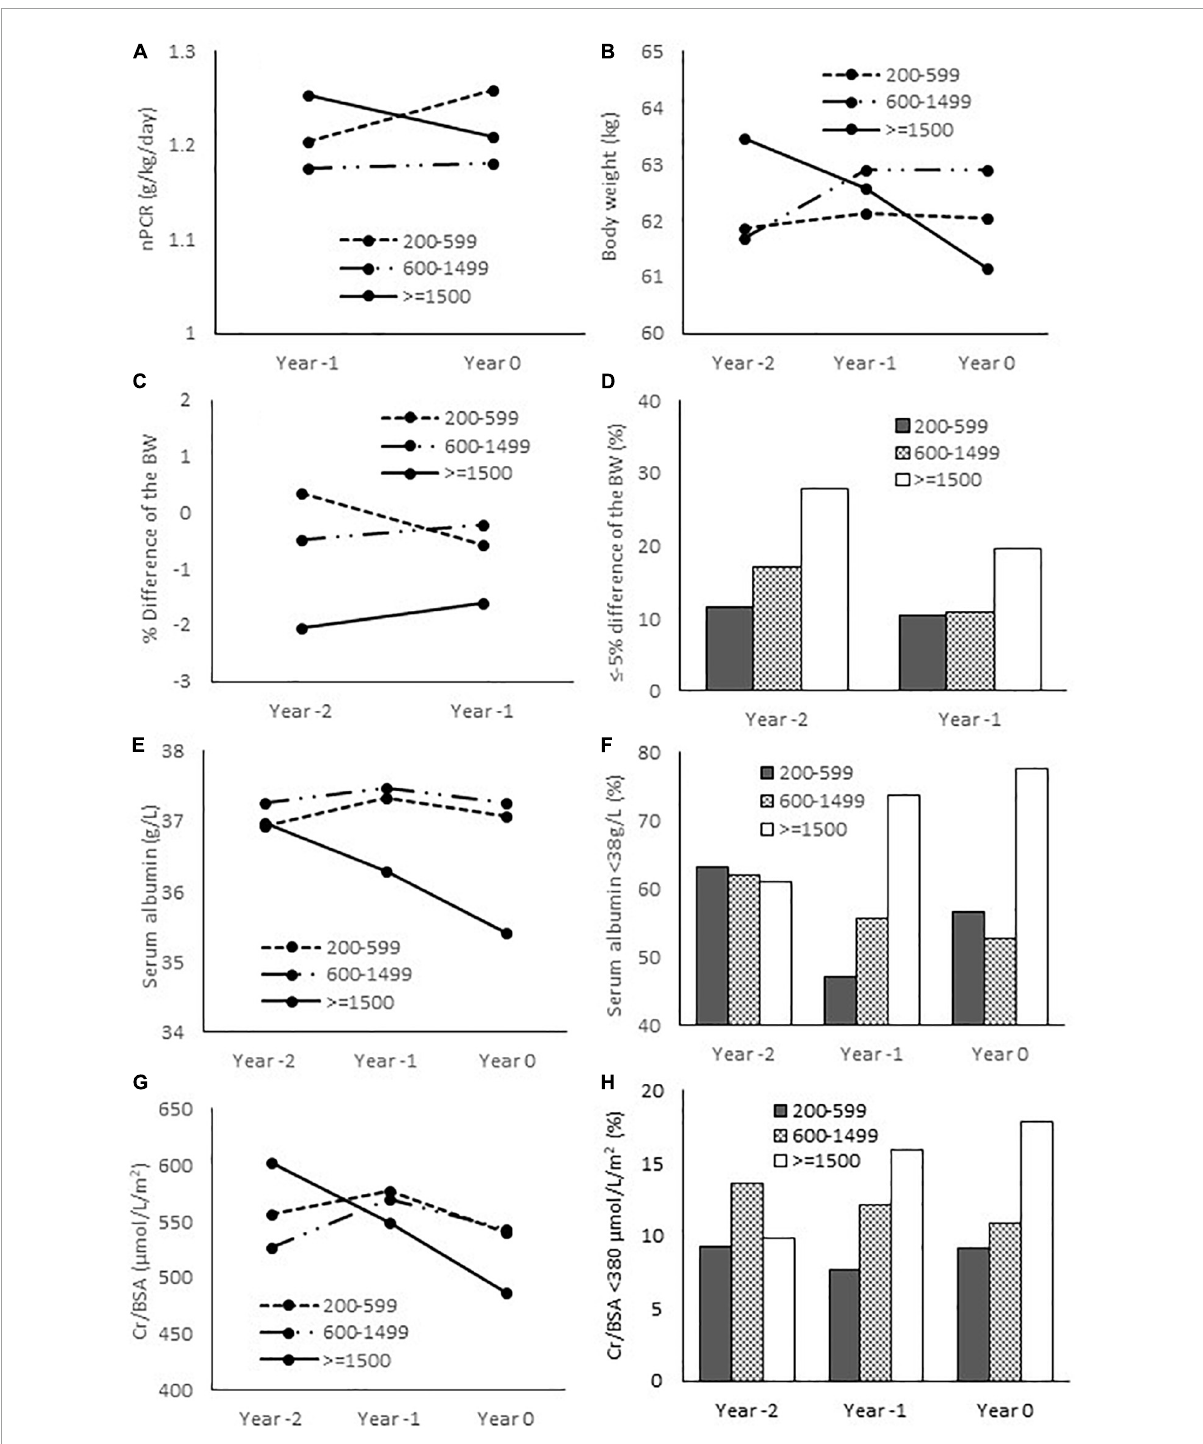
FIGURE3 Nutritional parameters at baseline and the preceding 1 and 2 years. (A) Normalized protein catabolic rate; (B) Body weight; (C) Relative difference of the body weight from baseline (Year 0); (D) Proportion of patients with ≤ -5% difference of the body weight from baseline; (E) Serum albumin; (F) Proportion of patients with serum albumin < 38 g/L; (G) Serum creatinine/body surface area; (H) proportion of patients with serum Cr/BSA < 380 µ mol/L/m 2 . nPCR, normalized protein catabolic rate; BW, body weight; Cr, creatinine; BSA, body surface